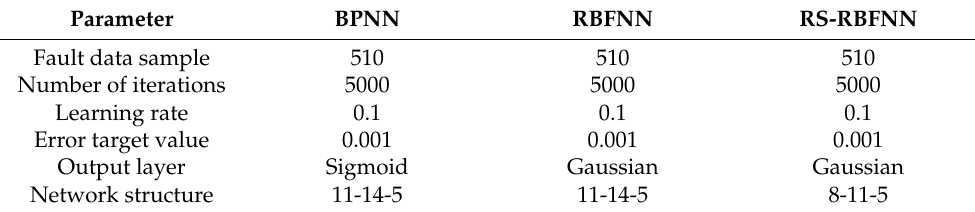
Table 6. The comparison parameter of the three neural network